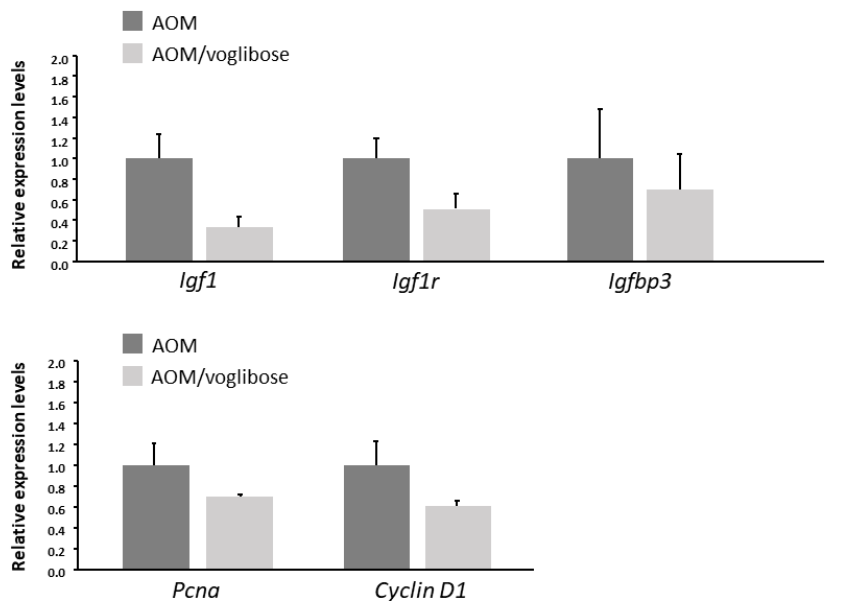
Figure 3. mRNA expression levels of proteins related to cell proliferation in the colonic mucosa of experimental mice. Relative expression levels of mRNA of IGF-1, IGF-1R, IGFBP-3, pcna, and cyclin d1 measured by qRT-PCR. 18S was used as the internal control. Data represent means ± S.E. from the various experimental groups. AOM,